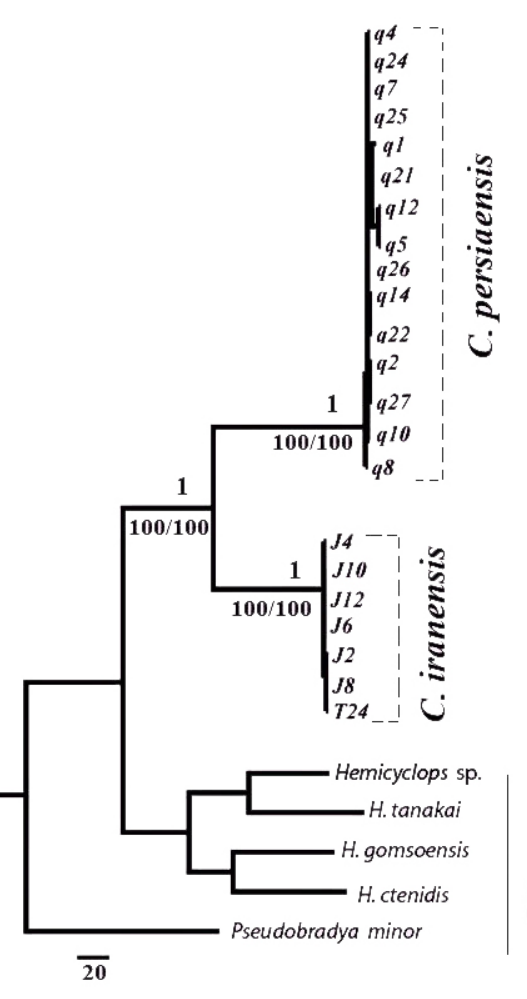
Figure 3. Maximum Likelihood (ML) gene tree based on partial CO1 gene sequences of the Clausidium species from the Persian Gulf and the Oman Gulf. The average branch lengths are proportional to the number of substitutions per site. Numbers above the nodes indicate Bayesian posterior probabilities and numbers below the nodes represent bootstrap support values for MP/ML (1000